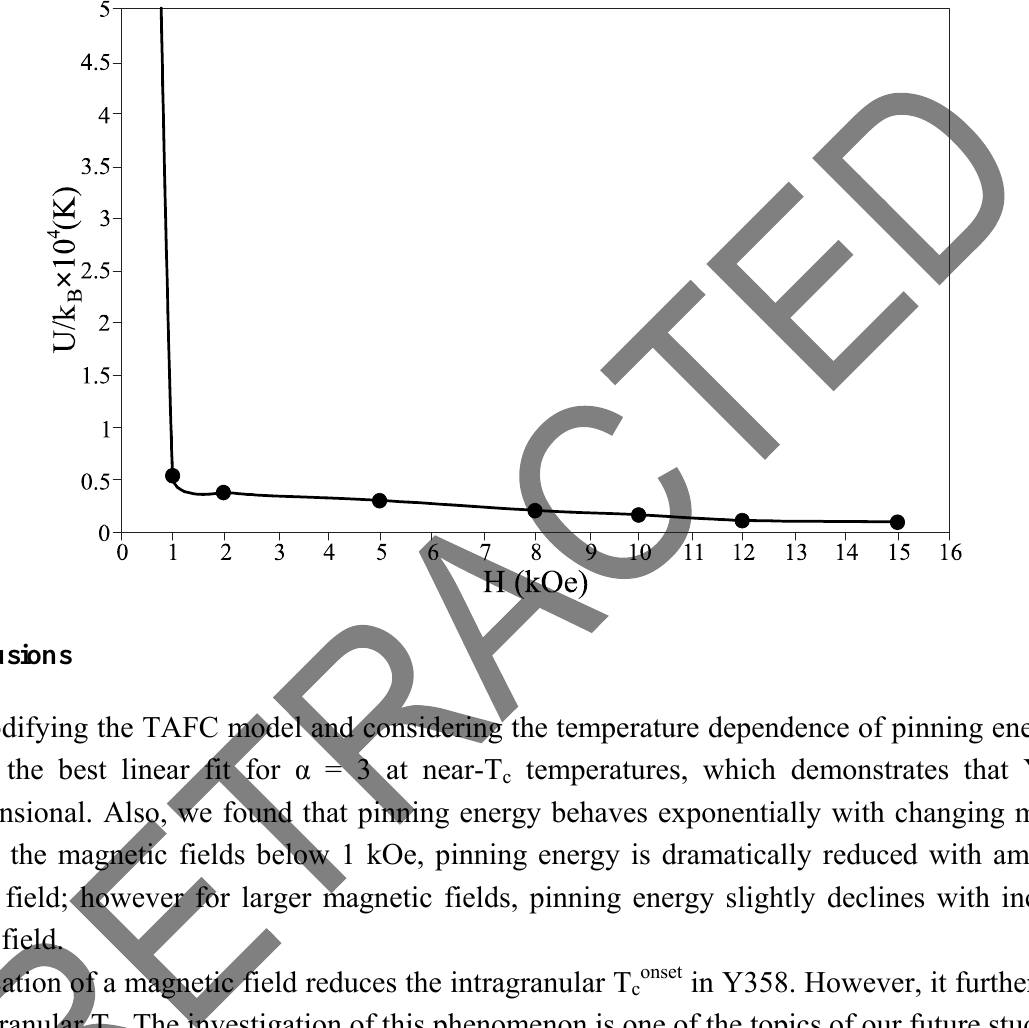
Figure 6. The effect of the applied magnetic field on pinning